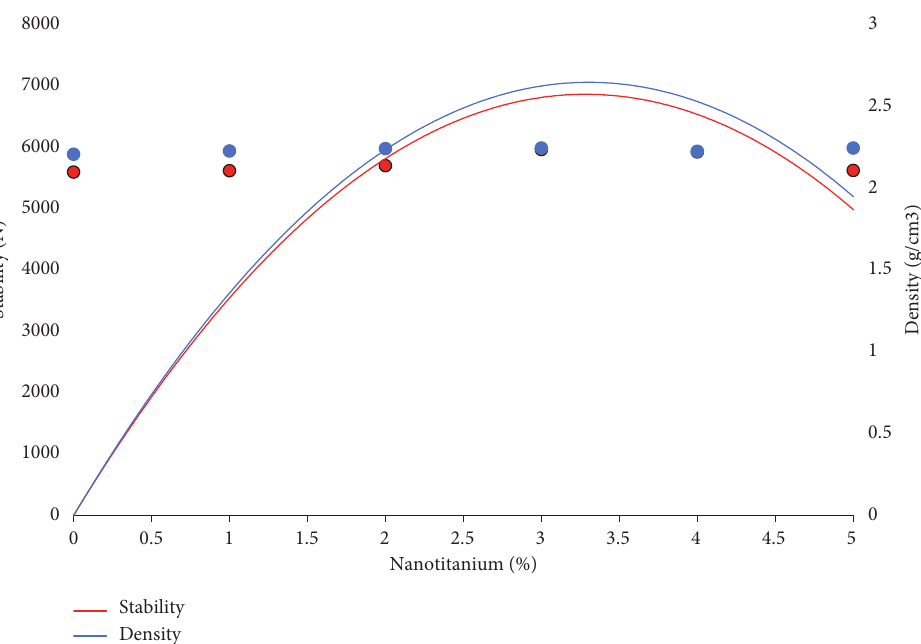
Figure 10: Stability and density against nano TiO